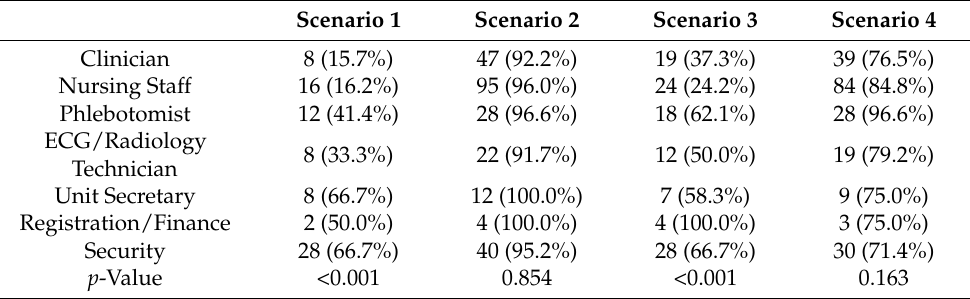
Table 5. Number (percentage) of respondents indicating the scenario demonstrated a reportable crime by ED staff